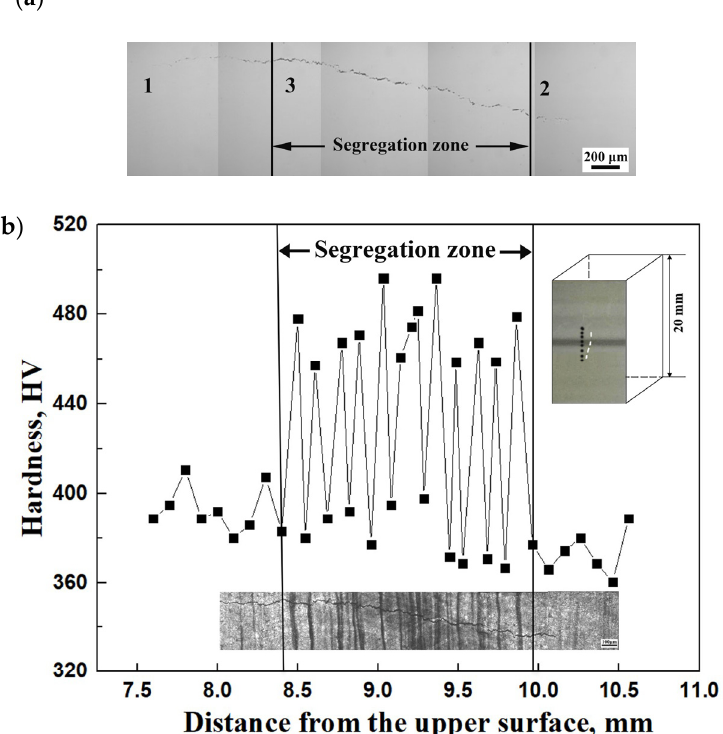
Figure 1. ( a ) Optical microscopy image of the morphology of a segregation crack and ( b ) the microhardness curve of a segregation band in a segregation zone (SZ).